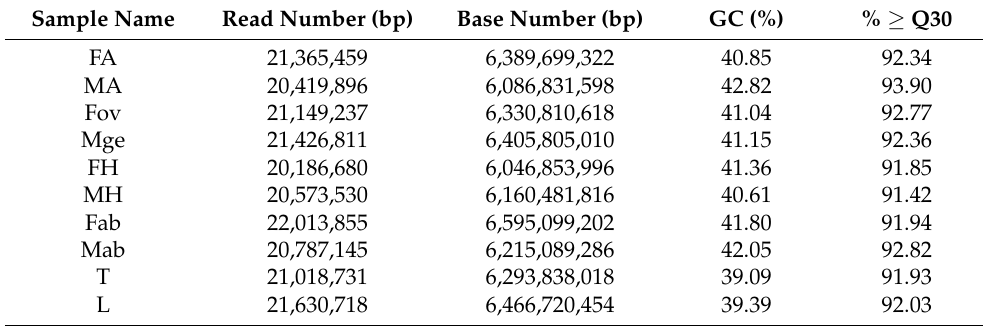
Table 2. Transcriptome assembly summary of B. dioryctriae